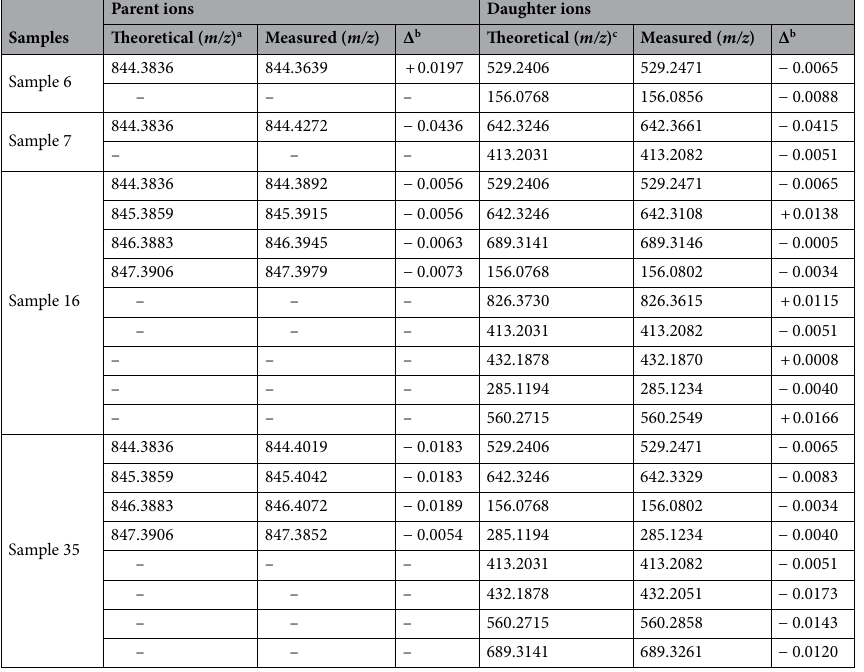
Table 1. Measured parent- and daughter ions in positive mice plasma samples. a As determined by ‘Isotope Distribution Calculator’ (MacCoss Lab, University of Washington, USA). b Difference between theoretical and measured m/z values. c As determined by ‘Fragment Ion